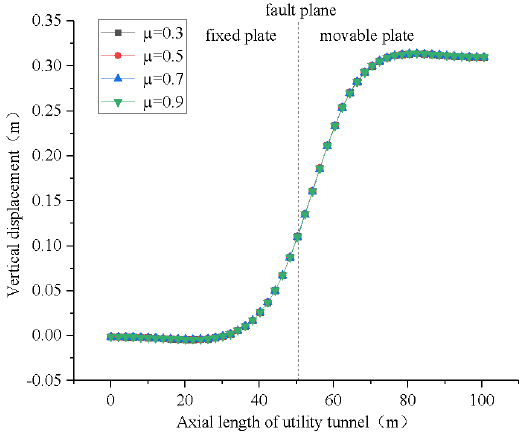
Figure 13. Vertical displacement distribution curve.